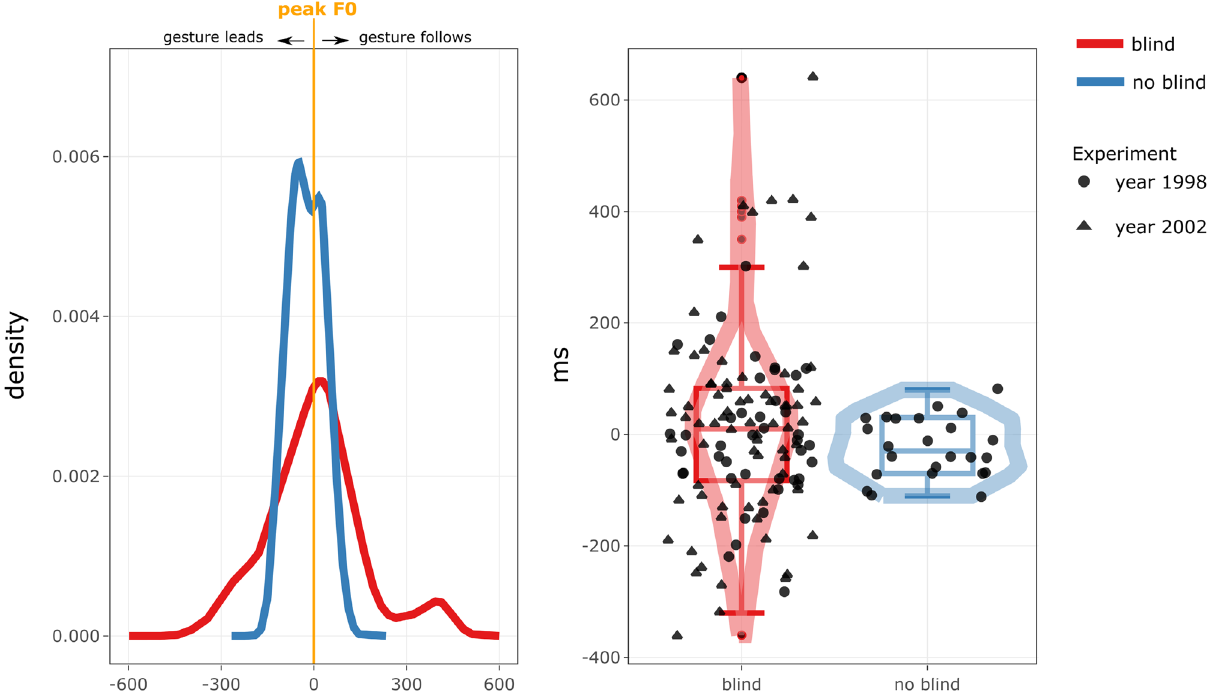
Figure 4. Timing between gesture peak speed and nearest peak F0. Note . The left panel shows the smoothed density distributions for the peak-velocity versus peak F0 timings in milliseconds (left panel: y-axis in probability units and x-axis in ms, right panel: y-axis in ms and x-axis reflecting condition). Negative (or positive) timings indicate that gesture’s peaks velocity leads (or follows) the occurrence of a nearest peak F0. The distribution widths indicate the timing variability, with larger widths showing more variable timing in gesture- speech synchrony. The right panel shows similar distribution information (violin plots) plus added information about the mean (box plots) as well as individual data points for the 1998 and 2002